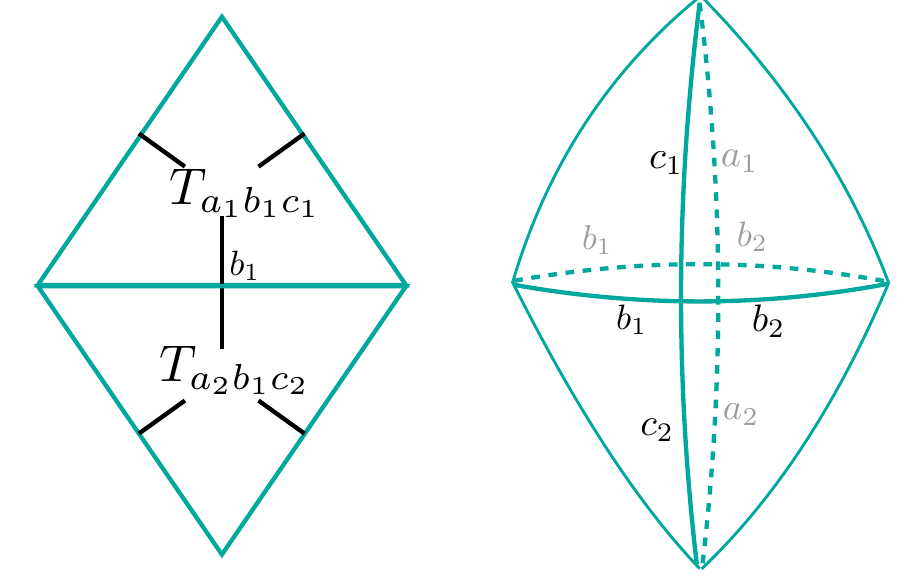
Figure 3 . The interaction T a T a T a T a corresponds to a gluing of four triangles 1 b 1 c 1 2 b 1 c 2 2 b 2 c 2 1 b 2 c 1 to form a \chunk" of three-dimensional space. We show the corresponding building block of space viewed \from the front" and \from the side". The identi(cid:12)cation of indices of two tensors corresponds to identi(cid:12)cation of the corresponding edges of the corresponding two triangles. This interaction is known as a \melonic" one in the literature due to the possible association of a melon with the right-hand